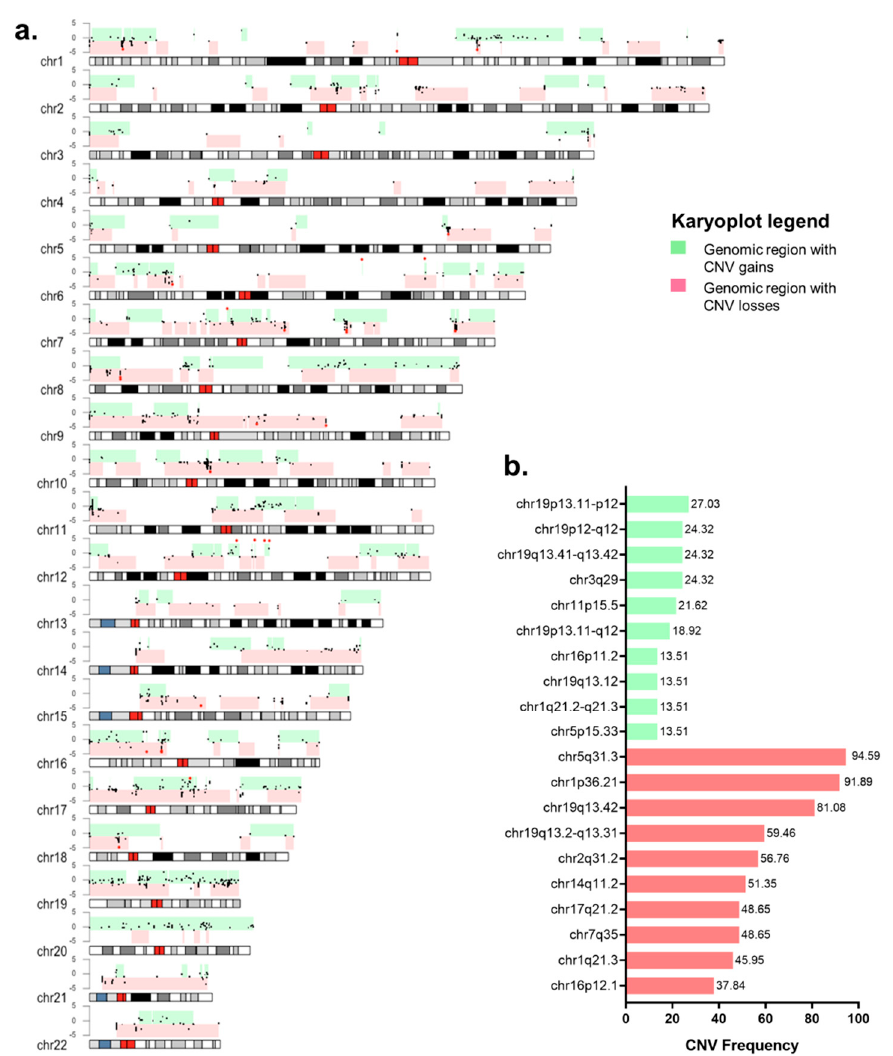
Figure 5. Structural variants present in Mexican patients with bladder cancer treated at the INCan (N = 37). ( a ) Karyoplot depicting the regions on each chromosome affected by copy number variations (CNV). The pink bars depict the genomic regions with CNV losses, and the green bars indicate the genomic regions with CNV gains on each chromosome present by one or more patients. The black dots within the pink and green bars indicate the start position of the CNV event per patient. The red dot indicates CNV events with a log2 greater than 3 or lower than ₋ 3 per patient; ( b ) Bar plot presenting the ten cytobands more frequently affected by CNV gains and losses in the cohort. Green bars indicate CNV gains, and pink bars indicate CNV losses.